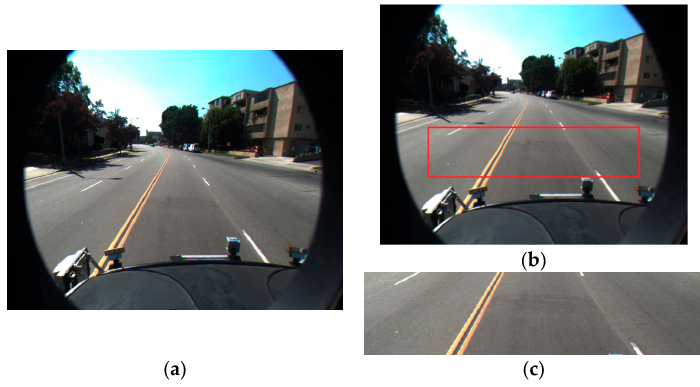
Figure 3. Region without or with road.